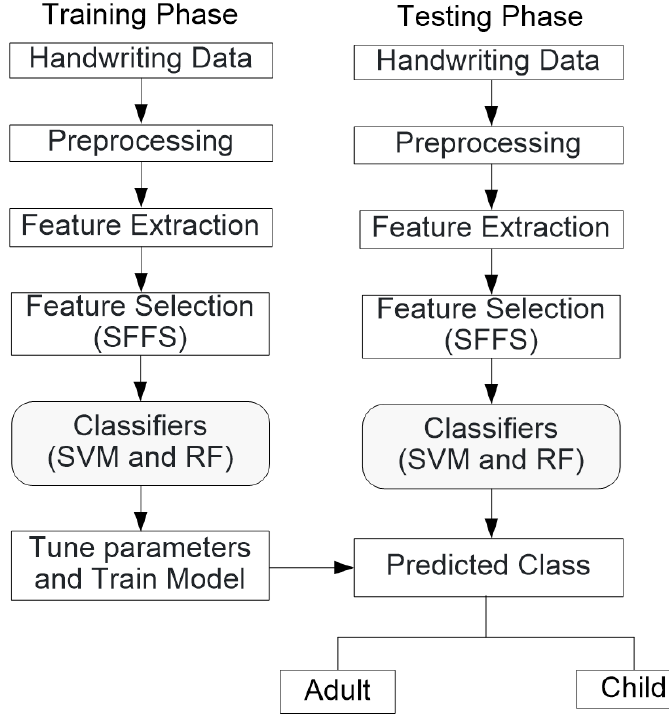
Figure 1. Proposed ML-based classification